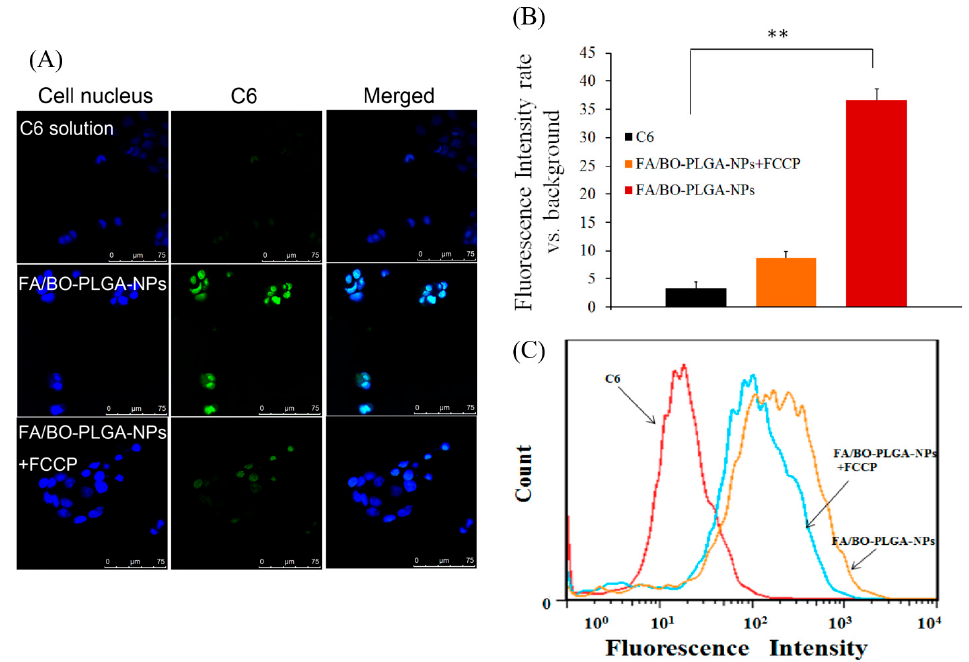
Figure 8. CLSM images ( A ) and fluorescence quantitative analysis ( B ) of Caco-2 cells after incubation with coumarin-6, FA/BO-PLGA-NPs and FA/BO-PLGA-NPs with carbonylcyanide p -trifluoromethoxyphenylhydrazone (FCCP) (1 mM) (coumarin-6 concentration of 300 ng/mL) for 4 h. Columns from left to right correspond to DAPI, coumarin-6 and an overlay of DAPI and coumarin-6, respectively. Flow cytometry results ( C ) of Caco-2 cells treated with coumarin-6, FA/BO-PLGA-NPs and FA/BO-PLGA-NPs with FCCP (1 mM) (coumarin-6 concentration of 300 ng/mL) for 4 h. * p < 0.05, ** p < 0.01.